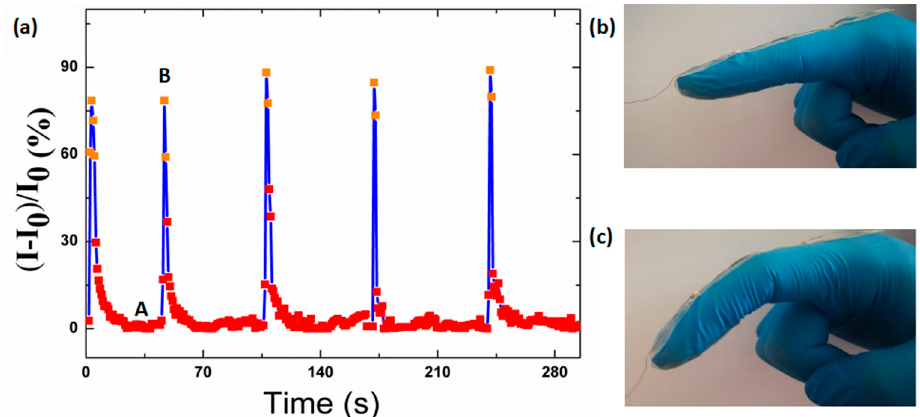
Figure 8. ( a ) Response of the strain sensor with spring-like configuration worked as wearable sensors in monitoring forefinger bending. A: The relaxing state of the strain sensor when the forefinger was bent suddenly. B: The maximum relative current change of a strain sensor to the response of bending the forefinger at the point the forefinger recovers to the original state. ( b ) Photographs of the forefinger in the original state. ( c ) Photographs of the forefinger in the bending state.